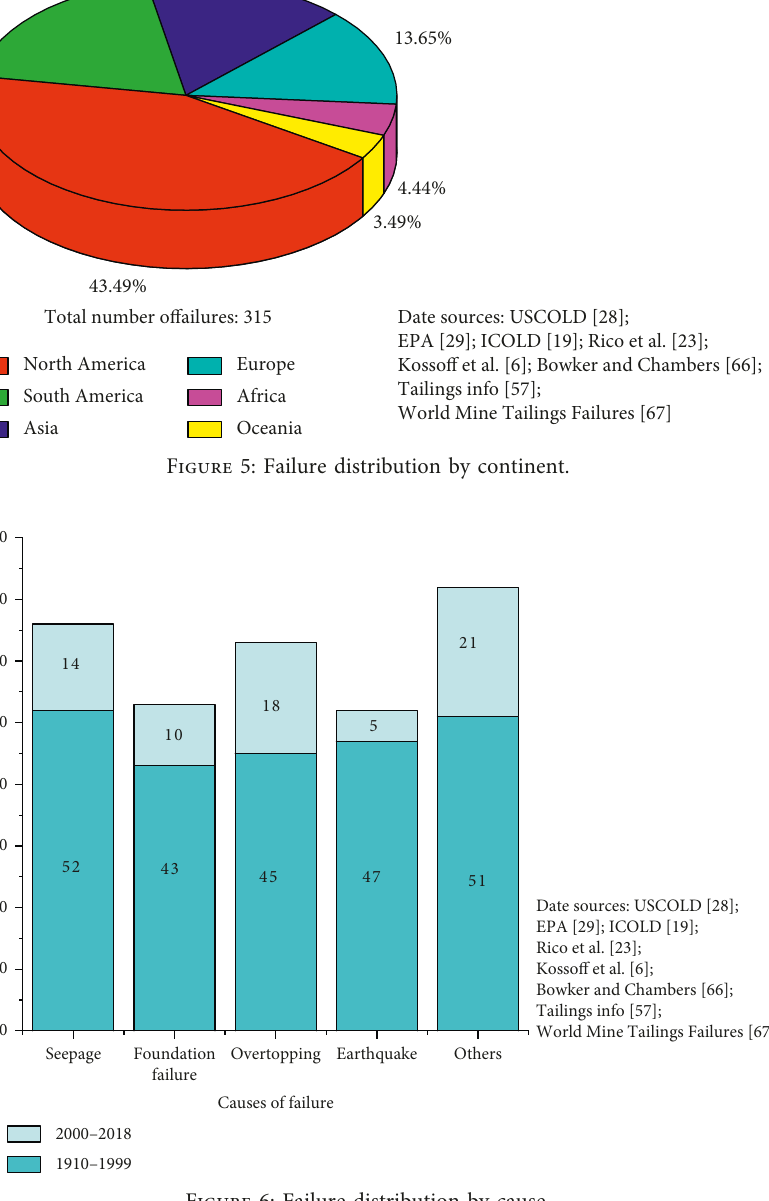
Figure 6: Failure distribution by cause.